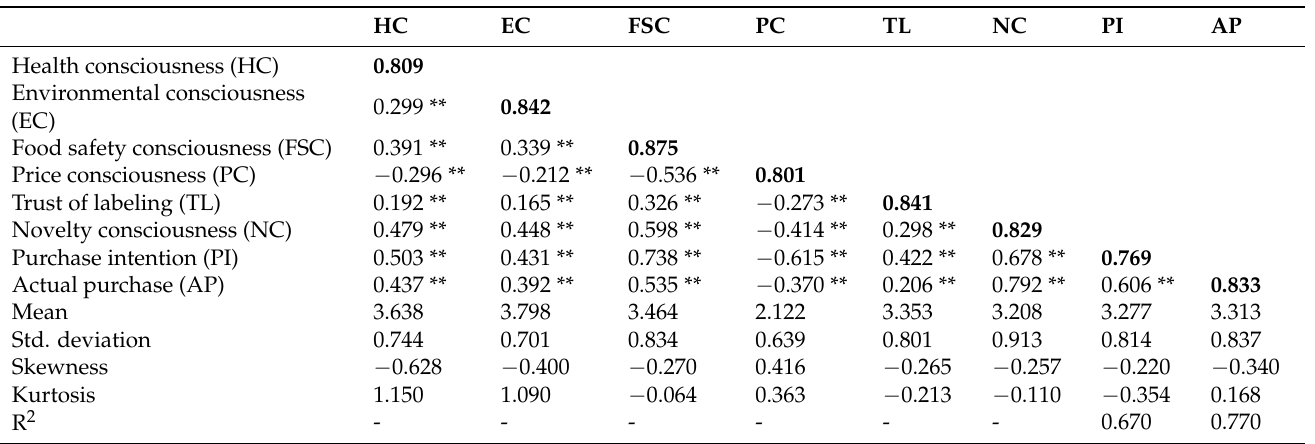
Table 2. Correlation of Latent Variables and Square Roots of AVE.